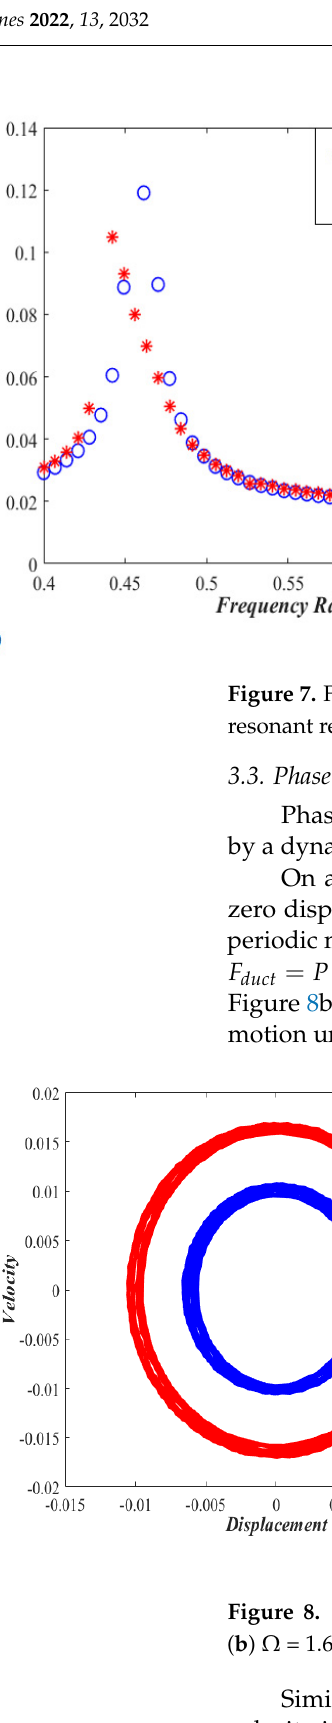
Figure 6. Frequency response curves for 𝑥 (cid:2869),(cid:2870) of the nonlinear dual HR (Case II).